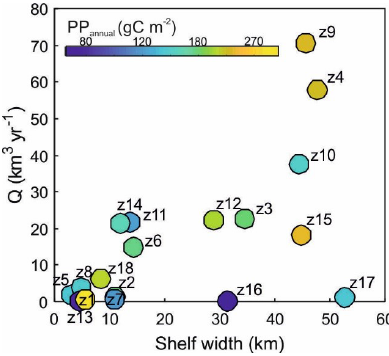
Figure 9. Relation between primary production, shelf width, and river discharge flow ( Q ). Bubble colors indicate the PP annual (gCm − 2 ) for each of the 18 defined zones (see Fig. 7 and Table